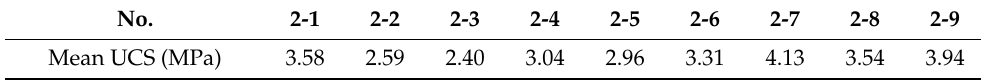
Table 3. The obtained mean UCS values of samples in row 2.